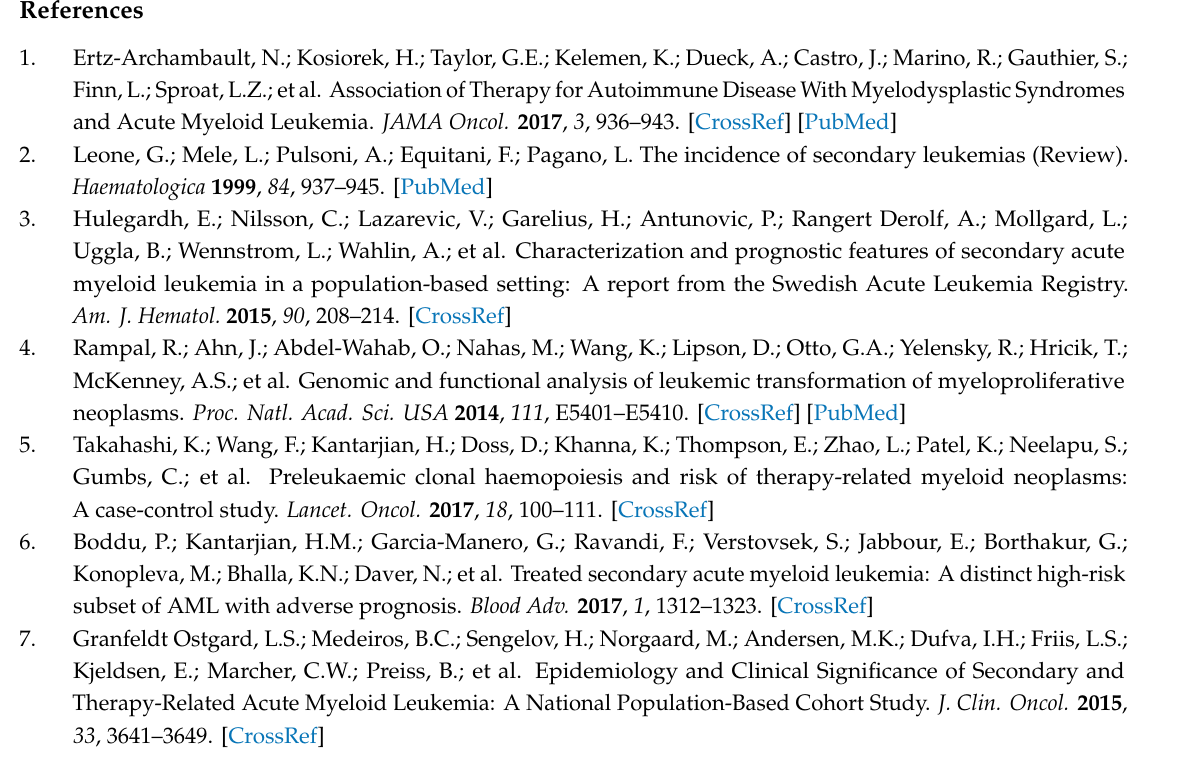
Table S1: Prospective trials which contributed patients to the current study. Table S2: Baseline characteristics, treatment period and intensity in patients with s-AML following MDS (group A), other malignancies (group B) or non-malignant conditions (Group C), being 16 to 85 years old at the start of treatment. Figure S1: Flowshart of patients included in the sAML database. Figure S2: OS according to the cause of s AML (A), patients’ age at diagnosis (B) and year of inclusion (C). Figure S3: Forest plot of the impact of HD-AraC on OS in younger patients from group A or B. Data request should be made via the EORTC website link: http: // www.eortc.org / data-sharing /